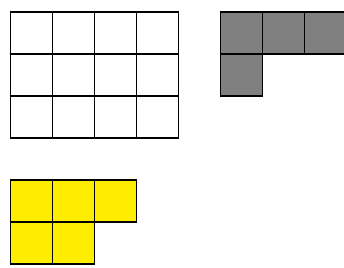
Figure 16 . Decomposition of a typical (i.e. long) representation (cid:22) . In this example, N 1 = 4 ; N 2 = 3, the representation (cid:22) ’ (7 ; 5 ; 4 ; 3 ; 2) is decomposed into (cid:20) ’ (4 ; 4 ; 4) (white), (cid:13) ’ (3 ; 1) (gray)